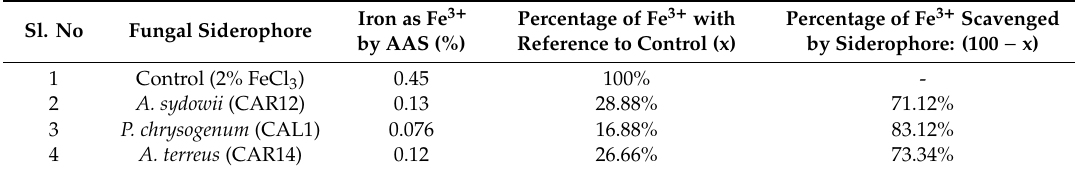
Table 3. Percentage of Fe 3+ scavenged by endophytic fungal siderophores.